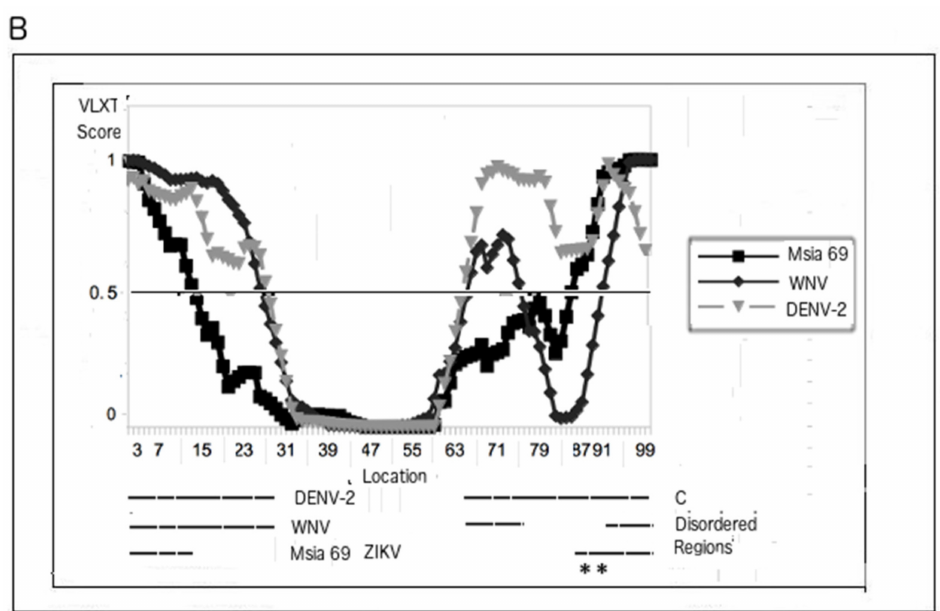
Figure 2. Comparative PONDR VLXT plots of the M and C proteins from various flaviviruses, including ZIKV. ( A ) M proteins of ZIKV (UniProt: A0A127AM58), DENV-2 (UniProt: P29990), and YFV (UniProt: Q1X881). ( B ) C proteins of ZIKV (UniProt: H8XX11, Msia69, see Table 1), WNV (UniProt: Q9Q694), and DENV-2 (UniProt: P29990). Regions with scores of 0.5 or above represent